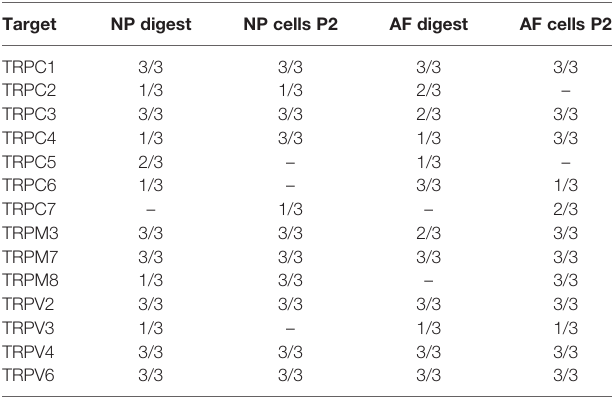
TABLE 3 | Primary screening: number of donors (min. n = 0; max. n = 3), in which the mRNA expression of all available TRP channel was detectable using TaqMan gene